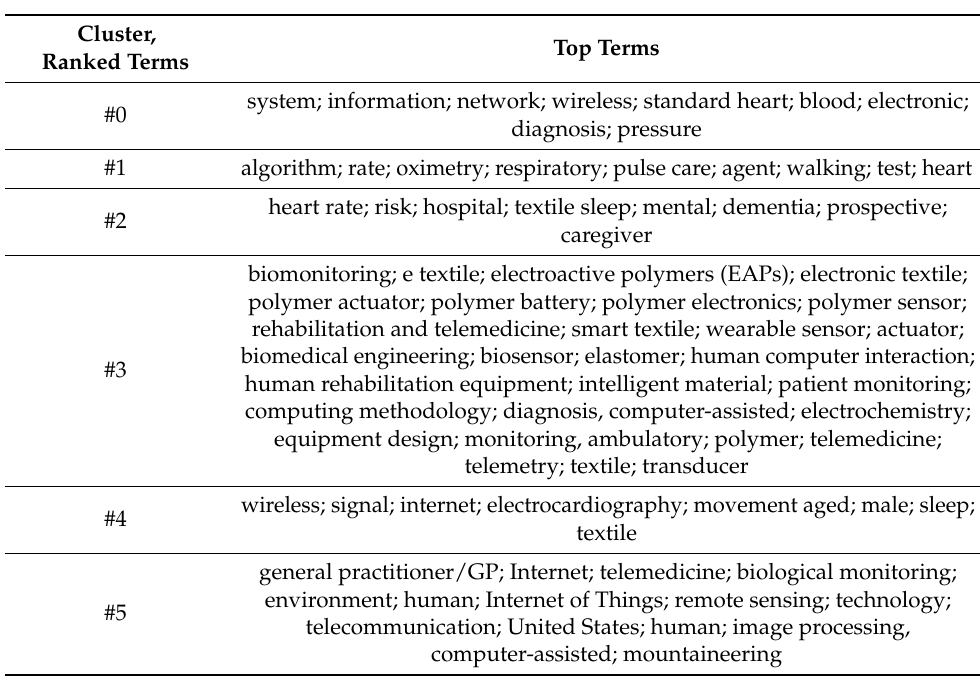
Table 6. Six research clusters in the field of